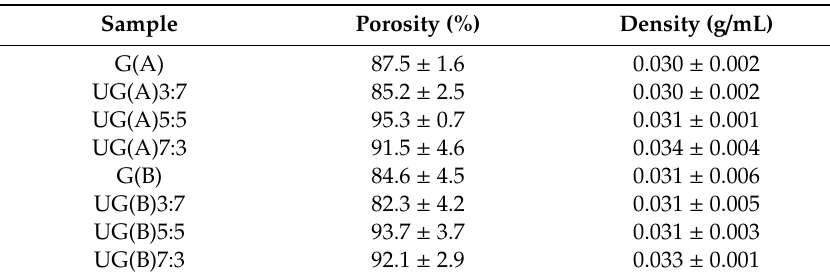
Table 1. Porosity and density of UG sca ff olds Sample Porosity (%) Density (g /